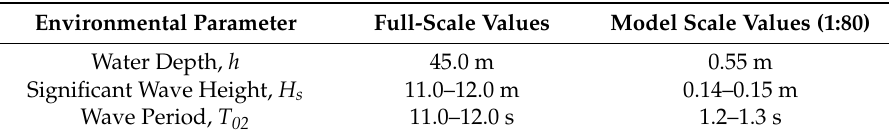
Table 2. 100-year environmental parameters in the North Sea.